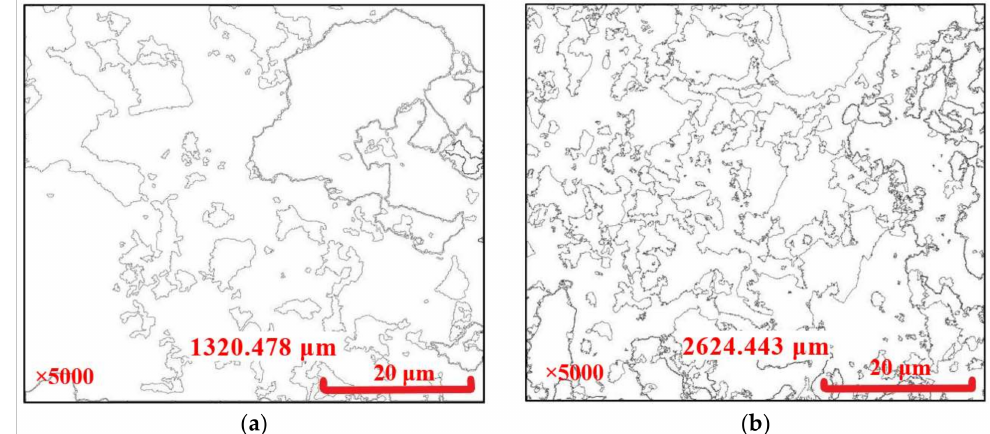
Figure 14. Quantitative analysis of boundaries between particles and pores: ( a ) no pumping agent added; ( b ) pumping agent